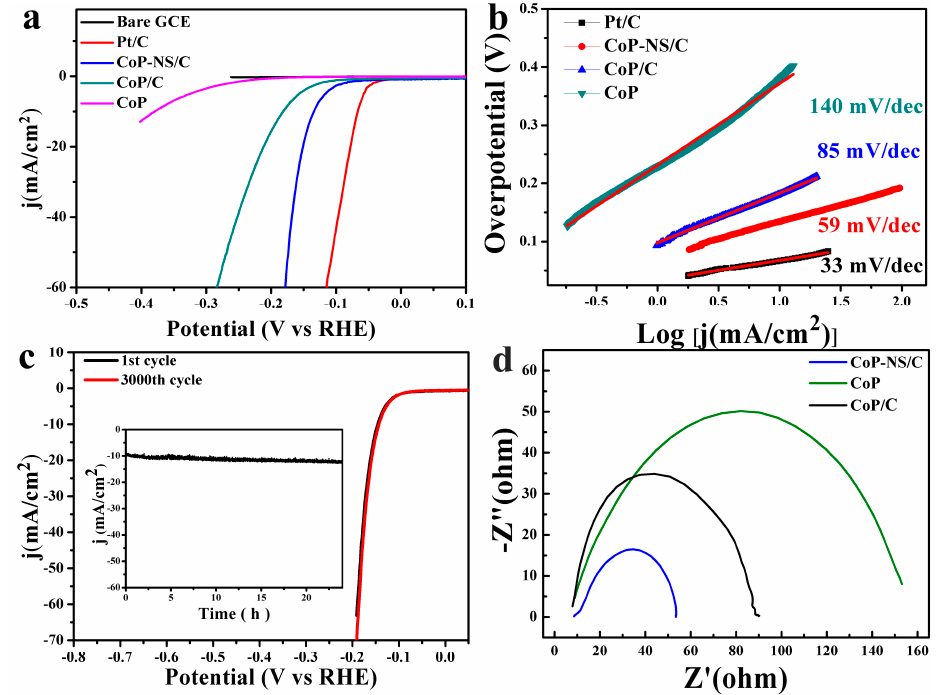
Figure 3. ( a ) IR-corrected polarization curves of CoP-NS/C, CoP/C, CoP, bare GCE (glass carbon electrode) and 20% Pt/C for HER in 0.5 M H 2 SO 4 at a scan rate of 10 mV/s; ( b ) Tafel slopes of CoP-NS/C, CoP/C, CoP, and 20% Pt/C, respectively; ( c ) polarization curves before and after 3000 CV cycles of the CoP-NS/C ranging from − 0.2 to 0 V (inset: time-dependent current density curves under static overpotentials of 140 mV of CoP-NS/C.); ( d ) Nyquist plots of the CoP-NS/C, CoP/C and at current density of 10 mA/cm 2 , respectively.